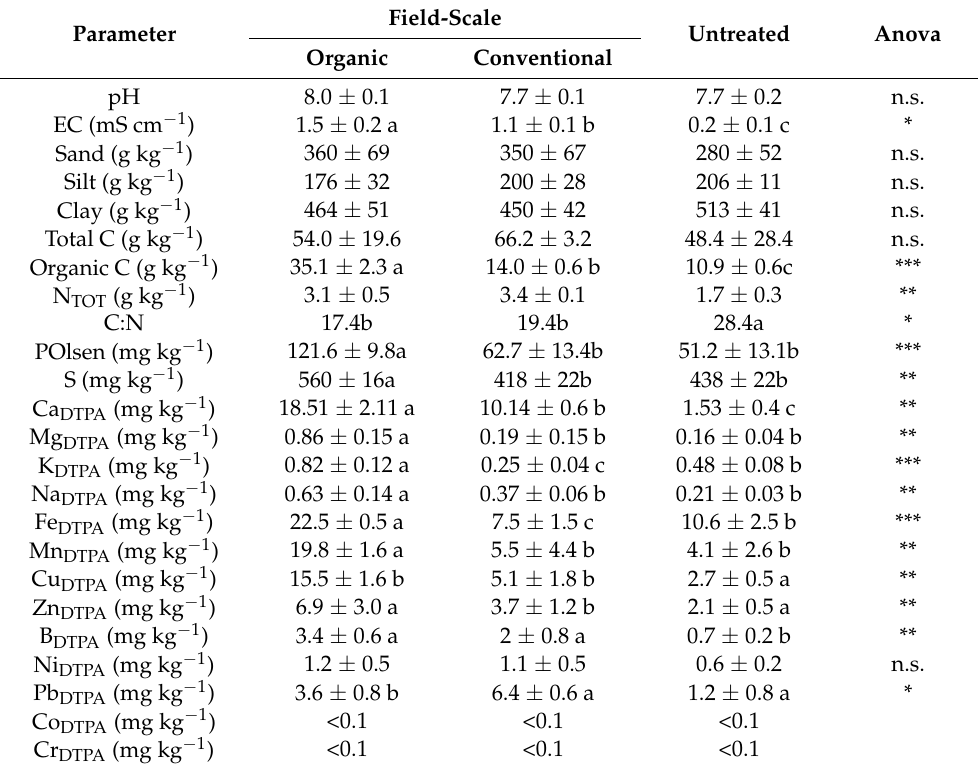
Table 3. Physical and chemical characteristics of the soil top layer of the field-scale amended with the wood-based compost (OFS), conventionally fertilized (CFS), and untreated (UNT) soil. Values represent the average of 10 replicates (main ± and standard